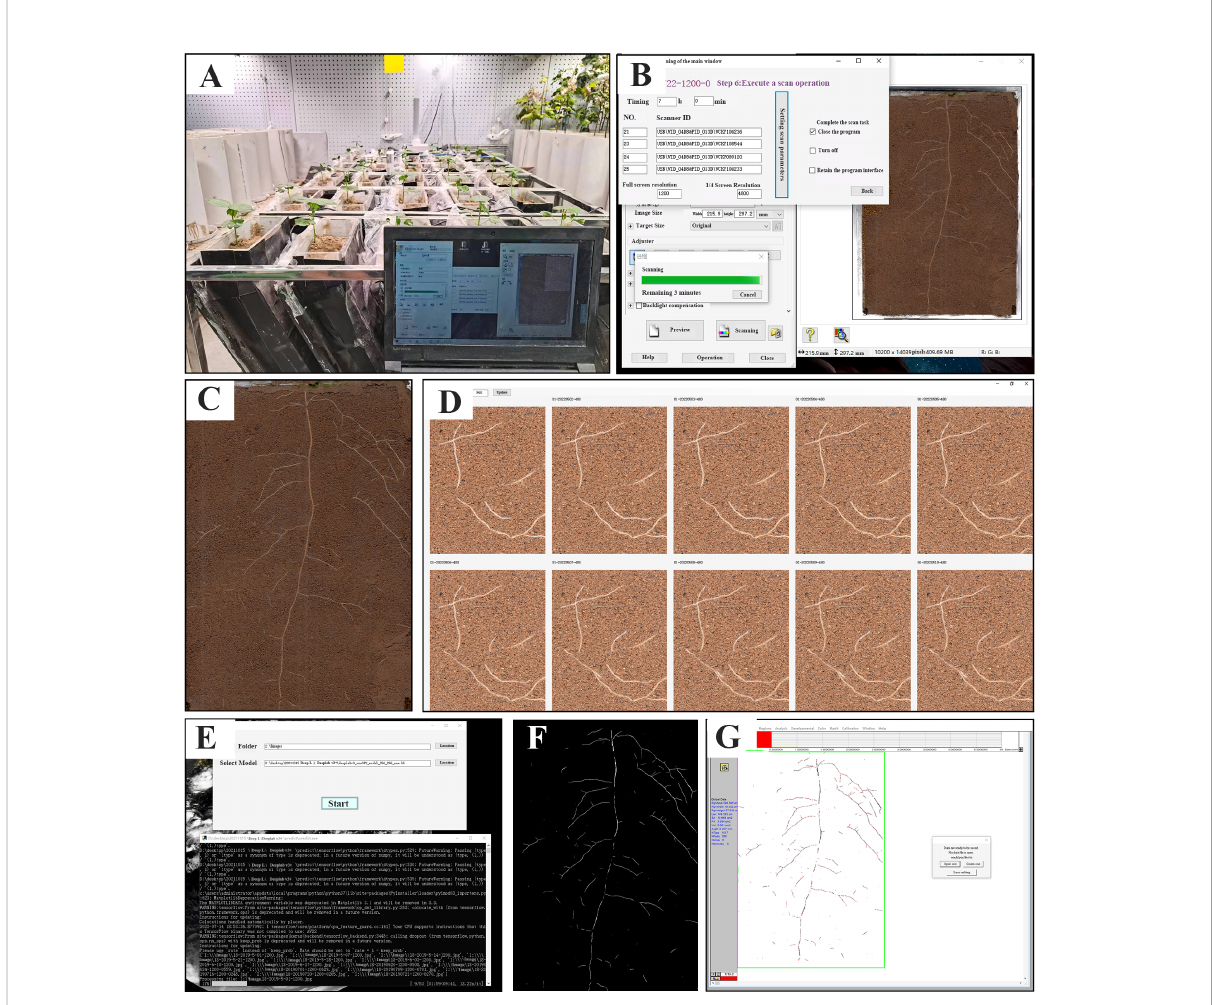
FIGURE 1 The composition and work fl ow of the RhizoPot platform for in situ root phenotyping. (A) RhizoPot in a greenhouse. (B) Operation interface of RhizoAuto. (C) In situ root images from a RhizoAuto-controlled fl atbed scanner. (D) Image comparison analysis tool RhizoComp. (E) Working photo of image segmentation tool DeepLabv3+. (F) Rendering of the segmented in situ root image. (G) The segmented images analyzed with WinRhizo